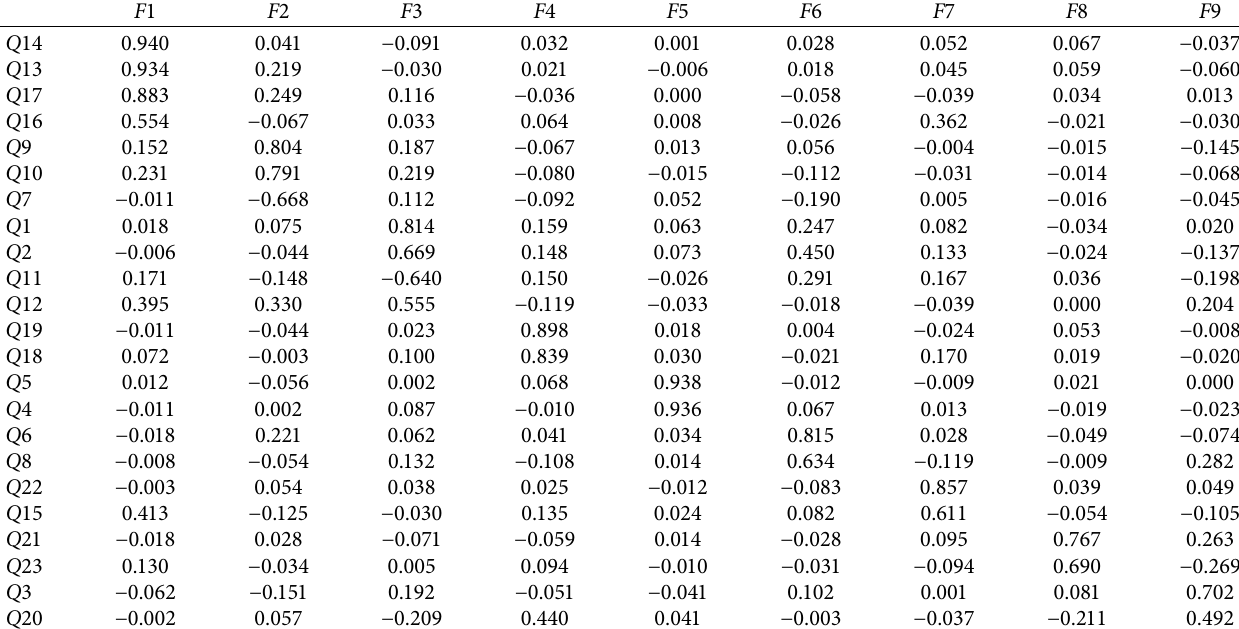
Table 6: Rotated component